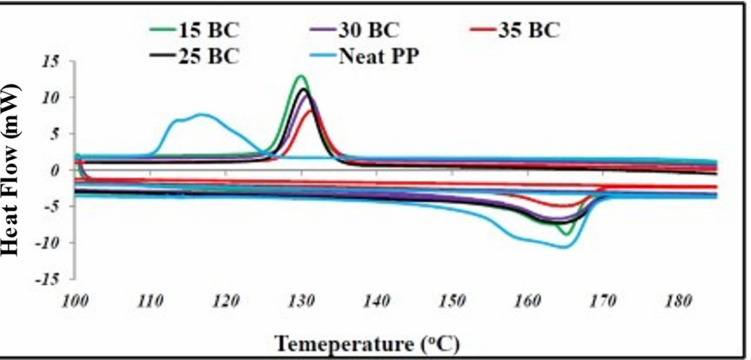
Figure 7. DSC thermogram of biochar filled polypropylene composites, no change in melting temperature was observed but a rise in crystallization temperature was observed due to the nucleation effect of biochar. Figure taken and modified from [5] with permission from Elsevier publication